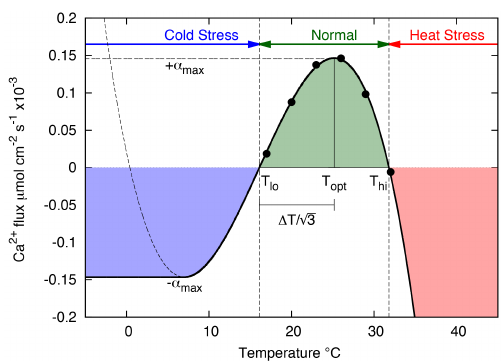
Figure 4. The functional form of adapted response α (thick black line) fitted to experimental data of Al-Horani (2005) (black circles). The adapted temperature range is shown in green and the tempera- tures at which heat stress and cold stress occur are shown in red and blue,